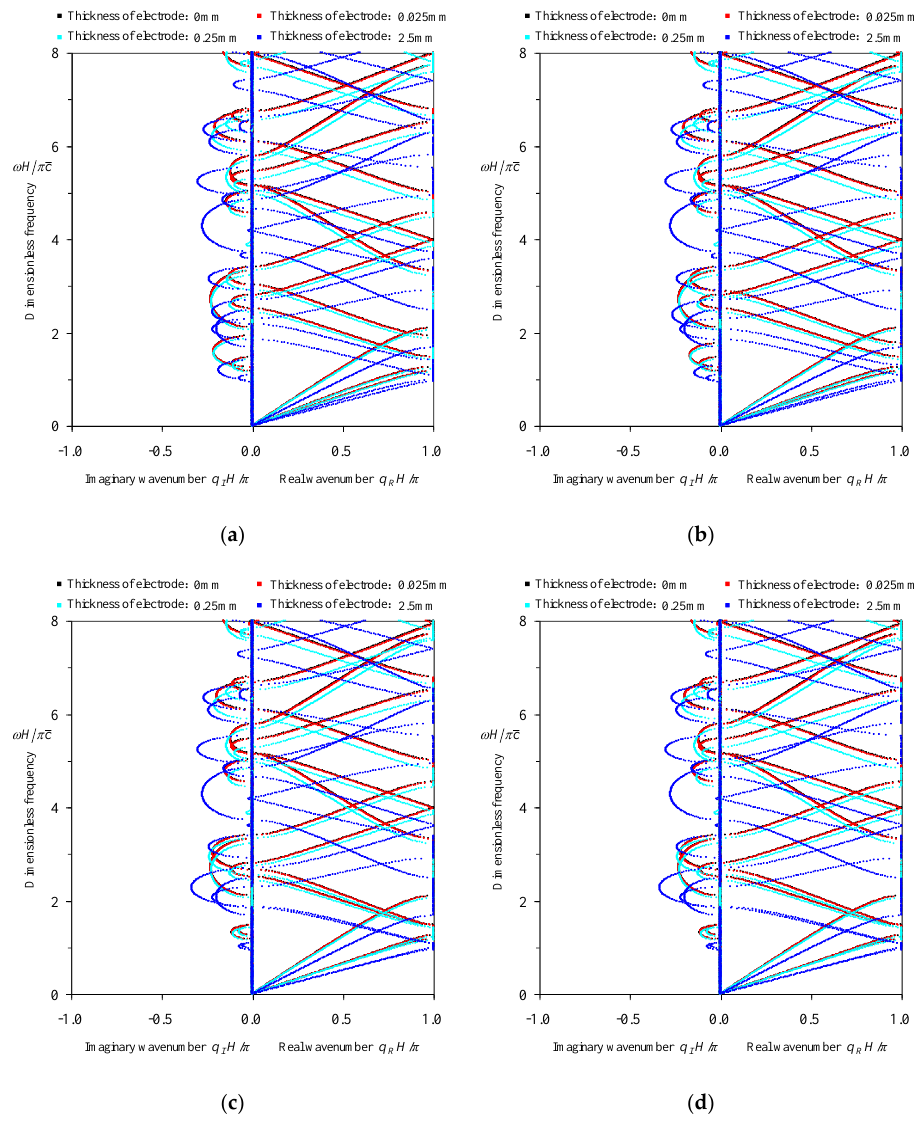
Figure 8. The effect of Brass electrode thickness on the wavenumber spectra of periodic Glass-Brass-(PZT-5H 2 )-Brass multilayers in cases of four electrical boundaries: ( a ) Electric-open condition; ( b ) Applied C / S = 1.02 pF/mm 2 condition; ( c ) Electric-short condition; ( d ) Applied K g = 5.0 × 10 8 V/m